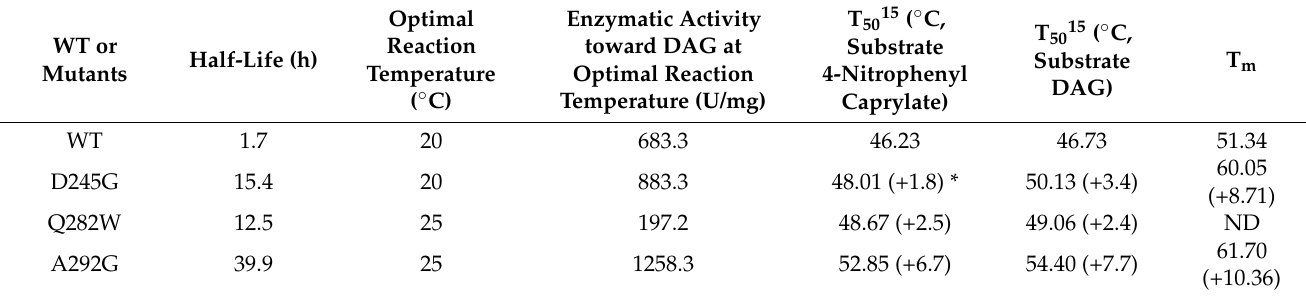
Table 1. Biochemical property of SMG1 and its